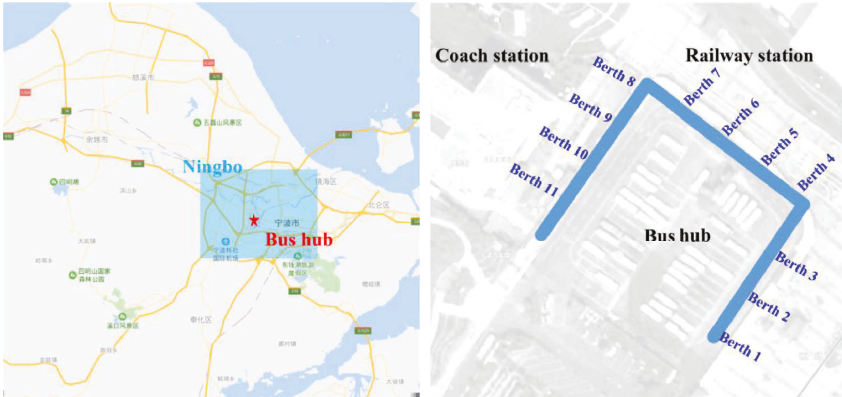
Figure 2: Siting and geographical layout of the selected bus hub. (a) Bus hub siting. (b) Hub geographical layout.